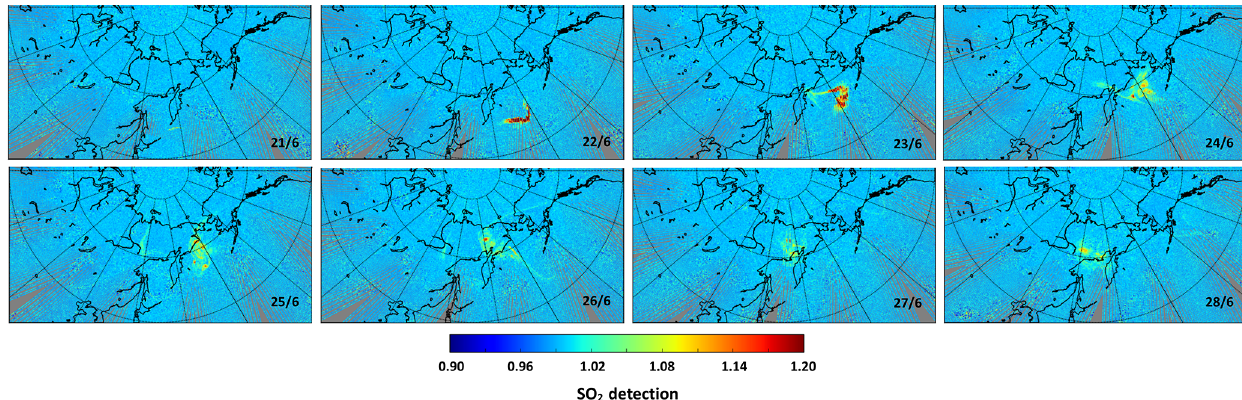
Figure A3. IASI SO 2 observations from 21 to 28